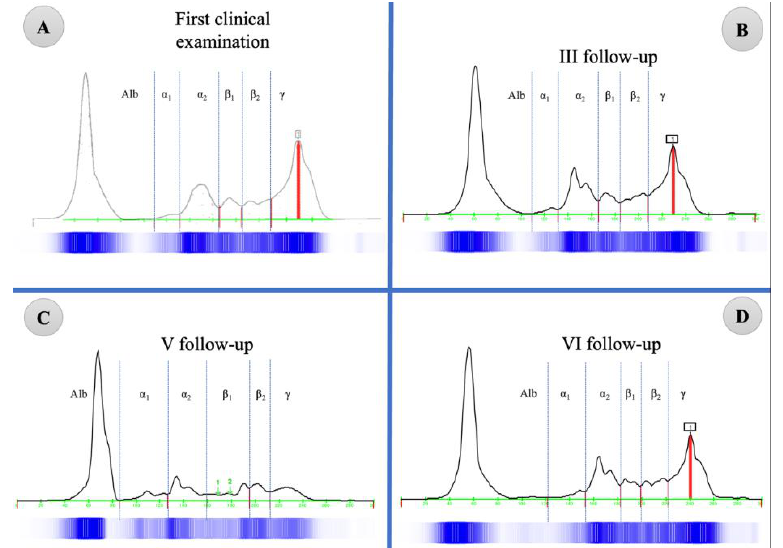
Figure 1. Modifications of the electrophoresis of serum proteins in a cat affected by Leishmania infantum and treated with allopurinol 10 mg/kg PO q 12 h. ( A ) At the first diagnosis before treatment with an antibody titre of 1:1280; ( B ) after six months of treatment; ( C ) at nine months follow-up with an antibody titre of 1:640; ( D ) before the final interruption of the therapy with an antibody titre of 1:320. Table 1. Cell blood count analyses, including red blood cells (RBC), haemoglobin (HGB), haemato- crit (HCT), Mean Corpuscular Volume (MCV), Mean Corpuscular Hemoglobin (MCH), Mean Cor- puscolar Hemoglobin Concentration (MCHC), white blood cells (WBC), and platelets (PLT) per- formed in a cat affected by Leishmania infantum and treated with allopurinol 10 mg/kg PO q 12 h at different time points; + / − , increasing and decreasing values.